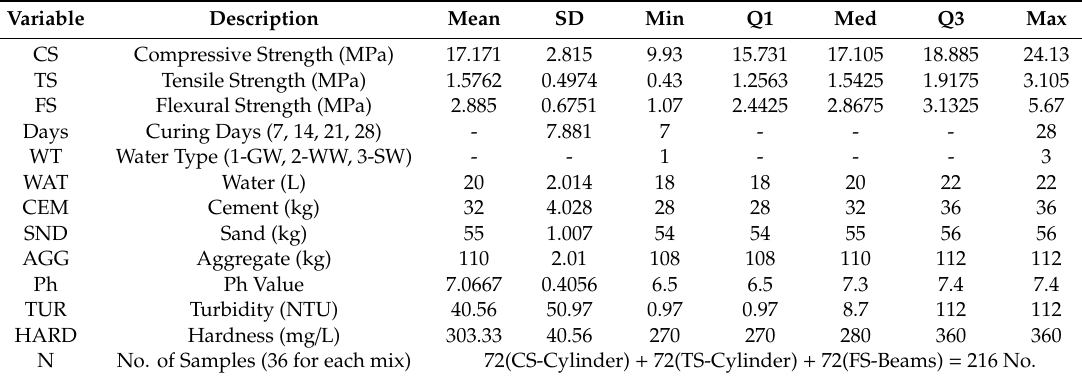
Table 3. Detailed range of concrete properties after testing.